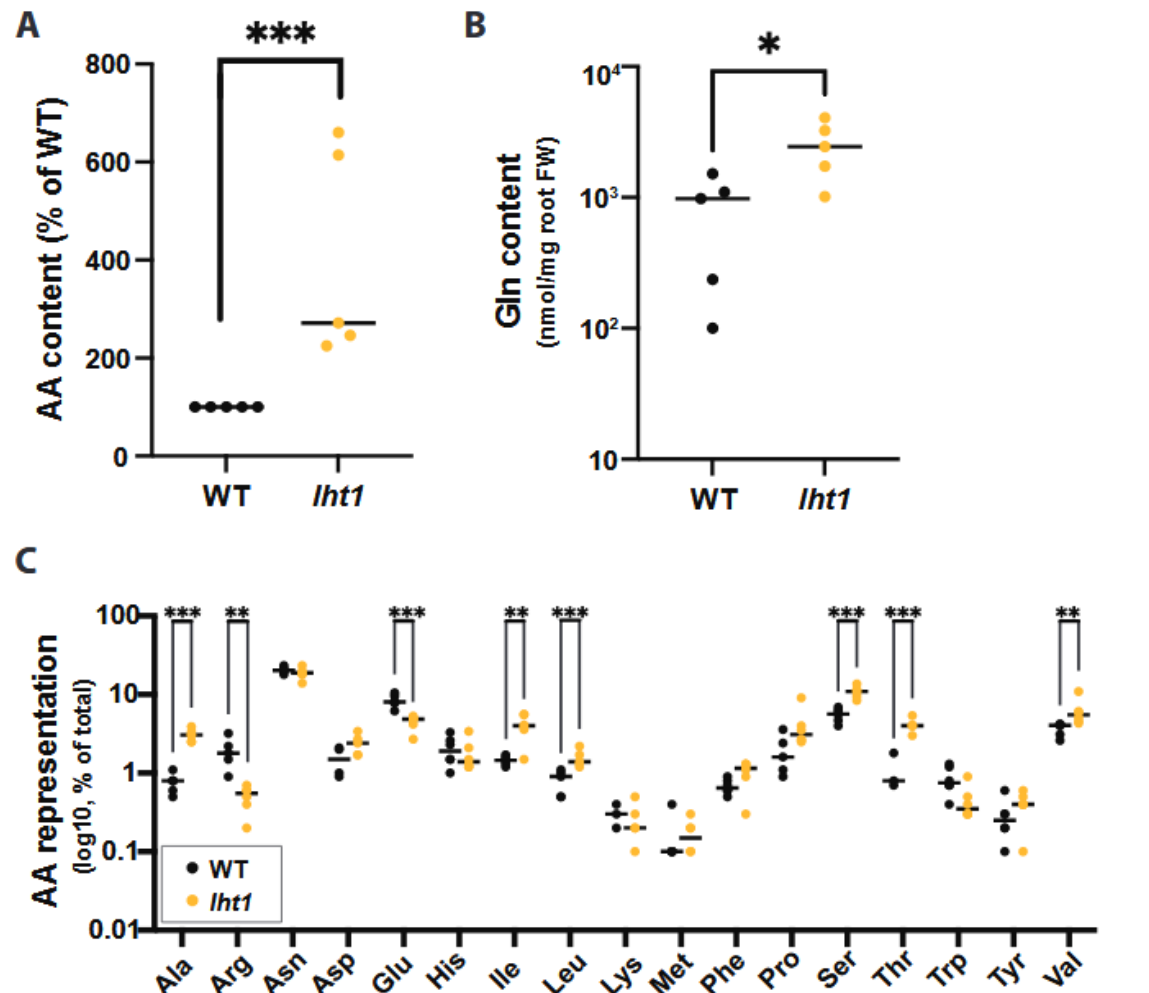
Figure 1. LHT1 modulates amino acid content of Arabidopsis root exudates. Across all panels in this figure, unless otherwise stated, data are from at least 3 independent biological replicates. In each biological replicate, at least 5 seedlings/plants or their products (e.g., exudates) were analyzed. Each dot in the scattered dot plots shows the median of the 5 or more seedlings/plants, and the median of all replicates is depicted as a bar. A two-sided Student’s t -test was performed for statistical comparison of two means, or a Welch’s t -test was used for two means with unequal variances when relevant. The p -values are represented as * ≤ 0.05, ** ≤ 0.01, and *** ≤ 0.005. Further experimental and analysis details are described in Section 5. ( A ) The lht1 mutant root exudates have higher AA content than wild-type (WT) exudates. Exudates obtained from 15-day-old lht1 or WT seedlings grown on 1X MS liquid medium containing 0.5% sucrose were filter-sterilized, and their total AA content was assessed using the L-Amino Acid Quantitation Colorimetric/Fluorometric Kit (see Methods). Each data point represents the median of 6 wells in each of 5 independent biological replicates. Data originally scored as nM of total L-AAs per mg of fresh root tissue are presented as a percentage of WT to be able to compare independent biological replicates in the same graph. ( B ) The lht1 mutant root exudates have higher glutamine (Gln) content than wild-type exudates. Root exudates obtained in ( A ) were treated with formic acid and profiled via LC-MS. Data is shown as a percentage of total AAs in lht1 and WT exudates. ( C ) The lht1 mutant root exudates show imbalanced AA content. Glycine data was omitted because unplanted MS medium contained background levels of glycine (2 mg/L). LC-MS analysis was performed on 6 independent samples per